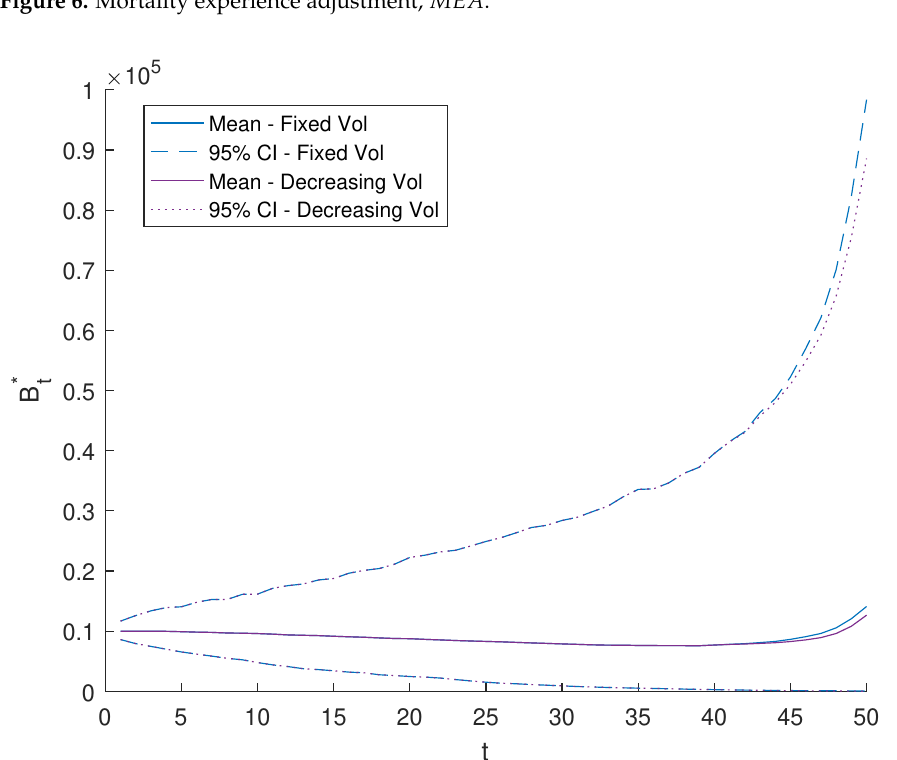
Figure 6. Mortality experience adjustment, MEA .